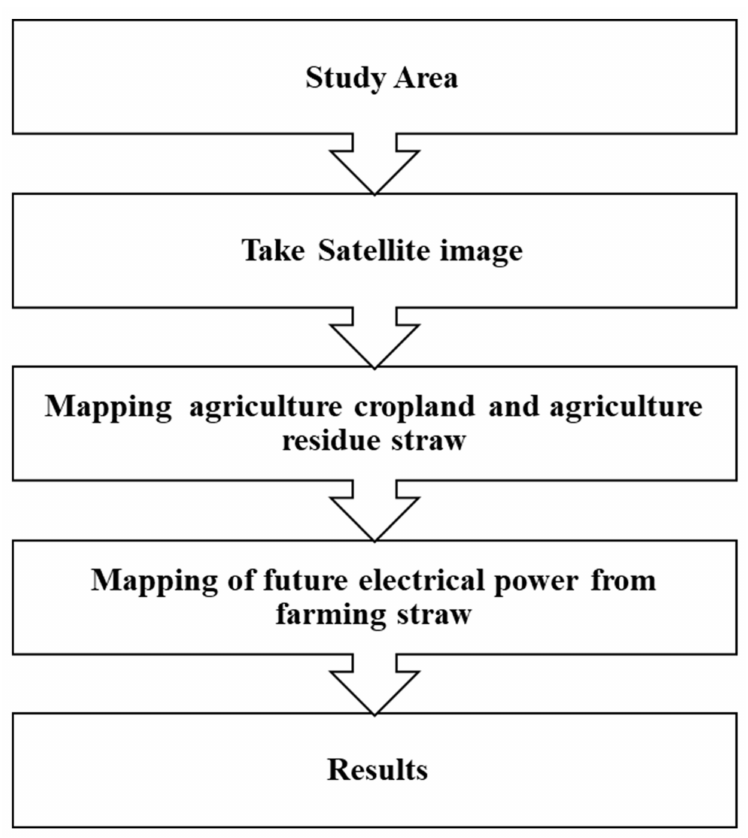
Figure 1. Methods to apply in GIS for estimating bioenergy